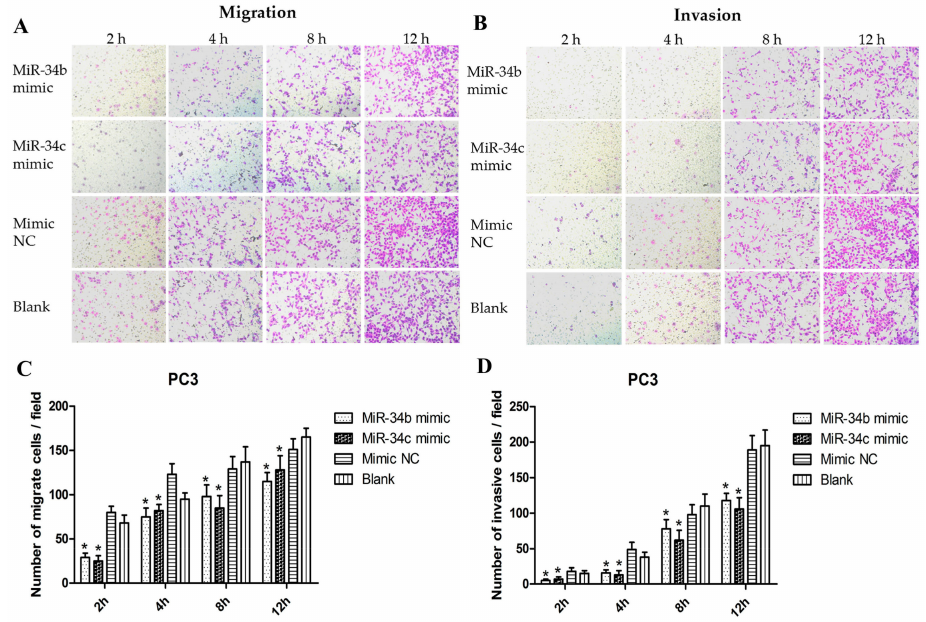
Figure 7. The capacity of migration and invasion of PC3 cells after transfection with miR-34b/c at 2, 4, 8, 12 h respectively. ( A , B ) Representative images of the invasion and migration of PC3 cells taken by an inverted microscope (20 × objective); ( C , D ) Quantitative analysis of cell migration and invasion. * p < 0.05 vs. mimic NC or blank group (basal migration without transfection). Per condition, three independent experiments were